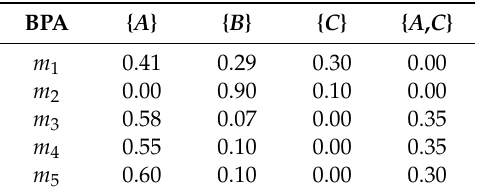
Table 1. Basic probability assignment (BPA) of the sensor data.